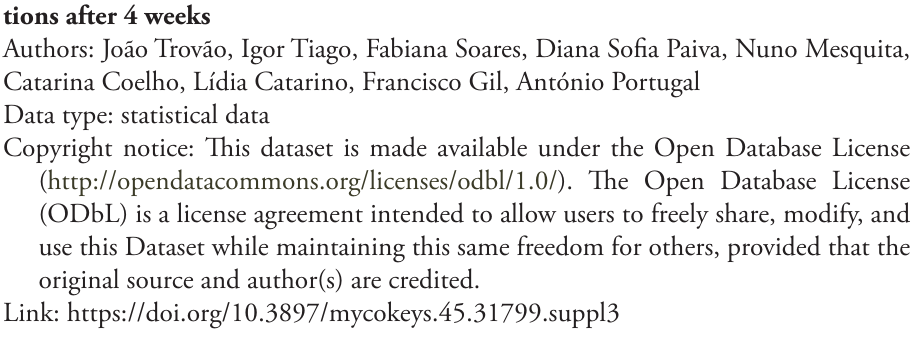
Figure S2. Growth of Aeminium ludgeri incubated at different NaCl concentra- tions after 4